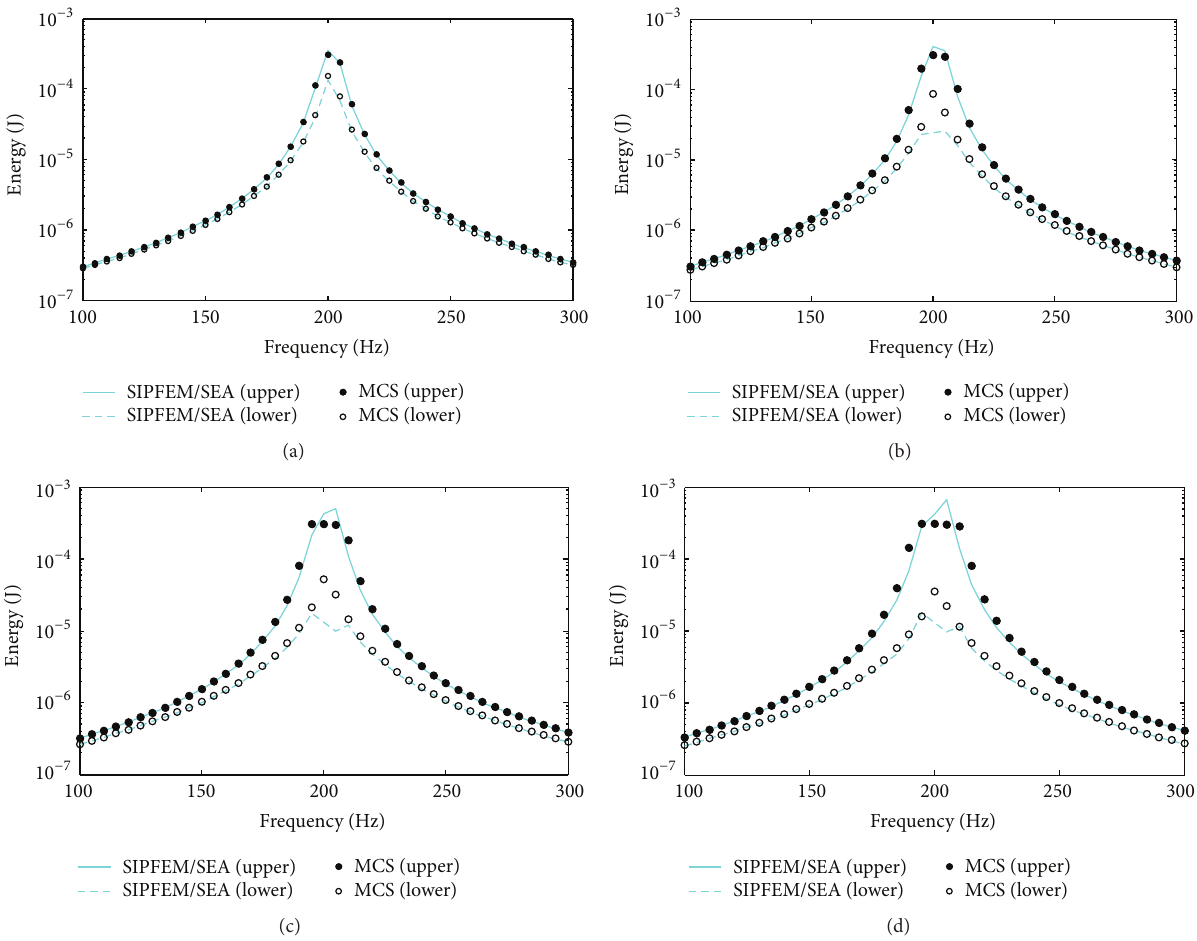
Figure 2: The bounds of the plate energy: (a) 𝛼 = 0.01 ; (b) 𝛼 = 0.02 ; (c) 𝛼 = 0.03 ; (d) 𝛼 = 0.04 .